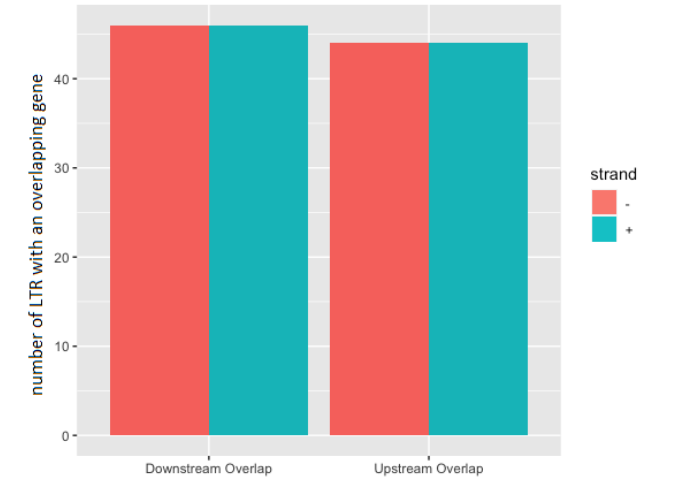
Figure 4. Number of sense LTR retransposons (strand+) and antisense LTR retransposons (strand-) with a downstream-overlap gene and upstream-overlap gene in Prunus mandshurica